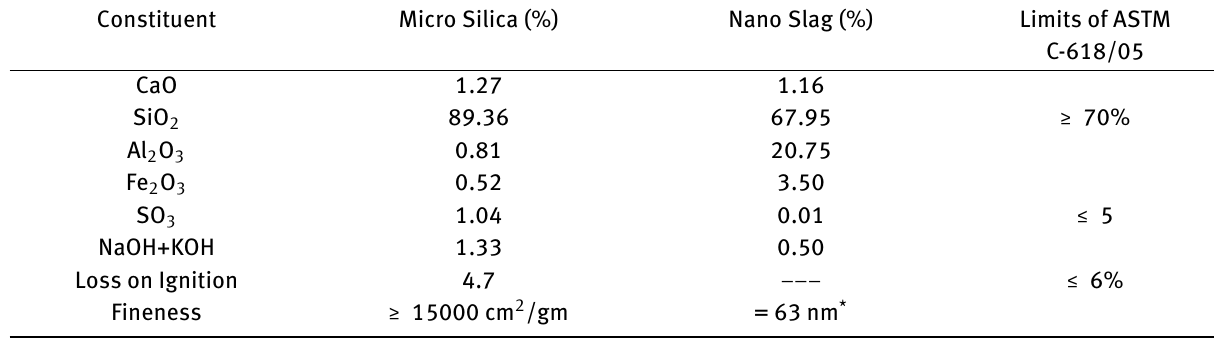
Table 1: Chemical composition of micro silica and nano slag * .